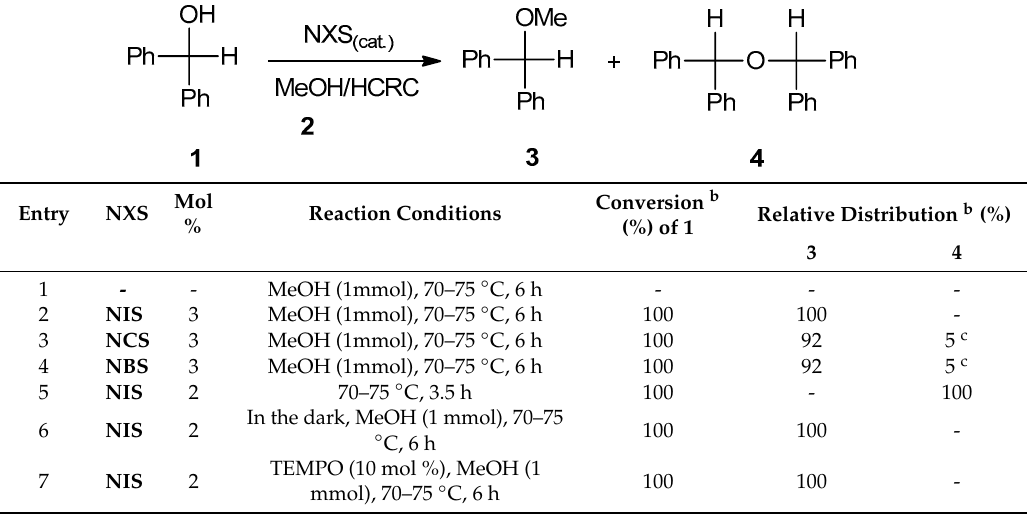
Table 1. Optimal reaction conditions for the highest conversion of diphenylmethanol 1 into the (methoxymethylene)dibenzene 3 in the presence of NXSs as mediators under HCRC a .